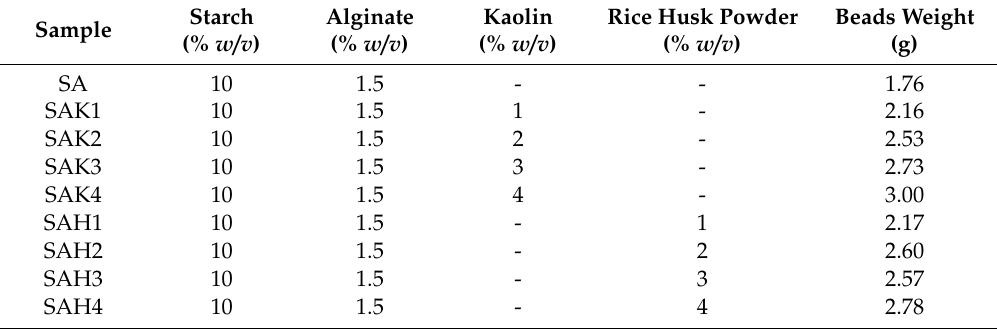
Table 1. Formulation parameters for the synthesis of starch–alginate beads, for which the amount of metalaxyl and the concentration of CaCl 2 solution in each formulation was 5 mg and 0.1 M,